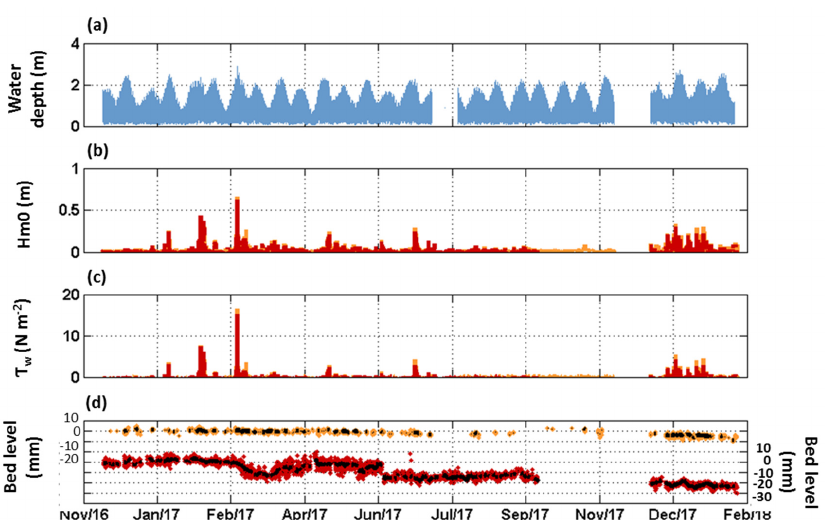
Figure 2. Time-series records of ( a ) water level, ( b ) spectral wave height for Spartina anglica station (yellow) and Spartina maritima (red) station, ( c ) wave bottom shear stress for S. anglica station (yellow) and S. maritima (red) station and ( d ) bed level variation within S. anglica (yellow–left axis) and S. maritima (red–right axis) and tide average bed level variation for both species (black line), for the entire survey period, between 28 November 2016 and 3 February 2018. The comparison between the critical bed shear stress for erosion between the two Spartina species (Figure 3) showed that higher values (up to 3 times) of wave bed shear stress are required for sediment mobilization within the exotic S. anglica which is con- sistent with the lower bed level variability verified within the stands of this species. However, the analysis of wave action over the bed, both through its energy and wave bed shear stress, did not reveal a clear tendency in terms of bed level response within the two Spartina species (data not shown).